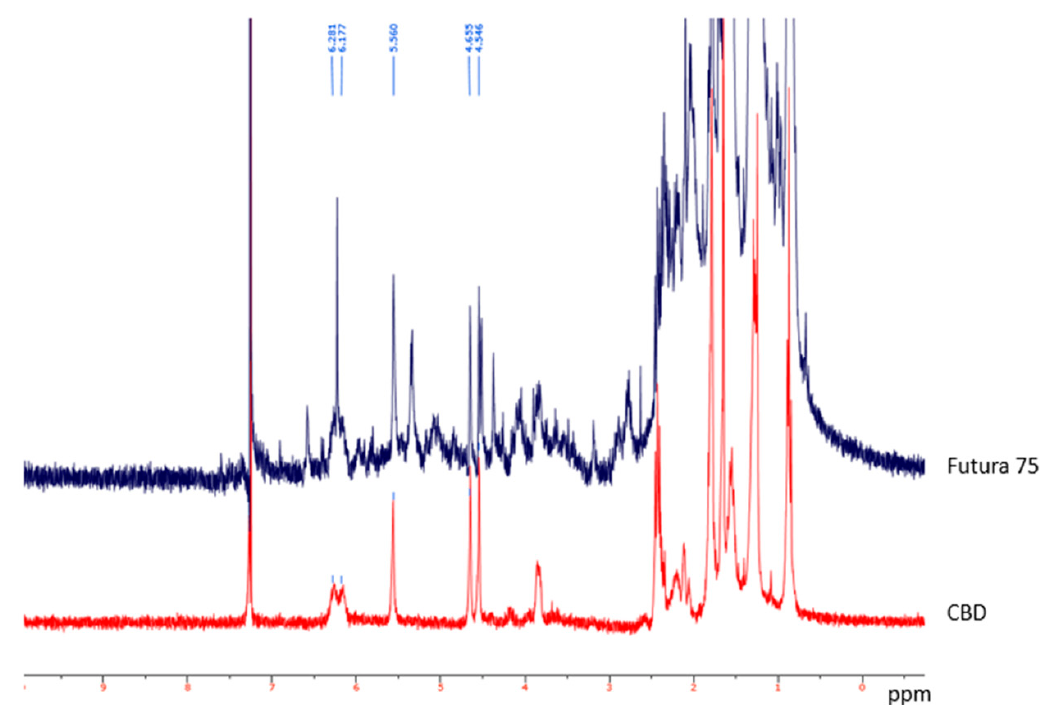
Figure 3. 1 H-NMR spectra of industrial hemp extract ( blue ) and cannabidiol standard solution ( red ). The cannabidiol protons signals are visible at 4.546, 4.655, 6.177 and 6.281 ppm and is detected in both cannabidiol standard and extract.